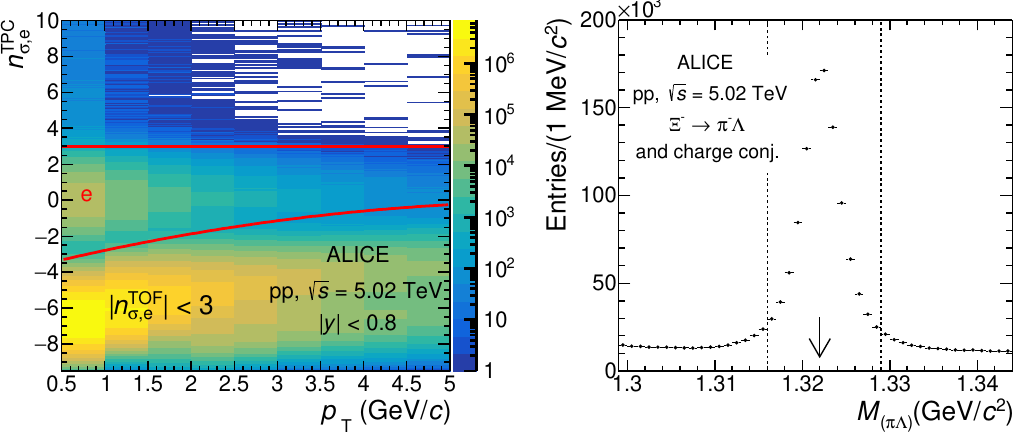
Figure 1 . Left panel: n TPC distribution as a function of the electron p T after applying the σ ,e particle identification criteria on the TOF signal (see text for details). Right panel: invariant mass distribution of Ξ − → π − Λ (and charge conjugate) candidates integrated over p Ξ − indicates the world average Ξ − mass [33] and the dashed lines define the interval in which the Ξ − candidates are selected for the Ξ 0 reconstruction (see text for c